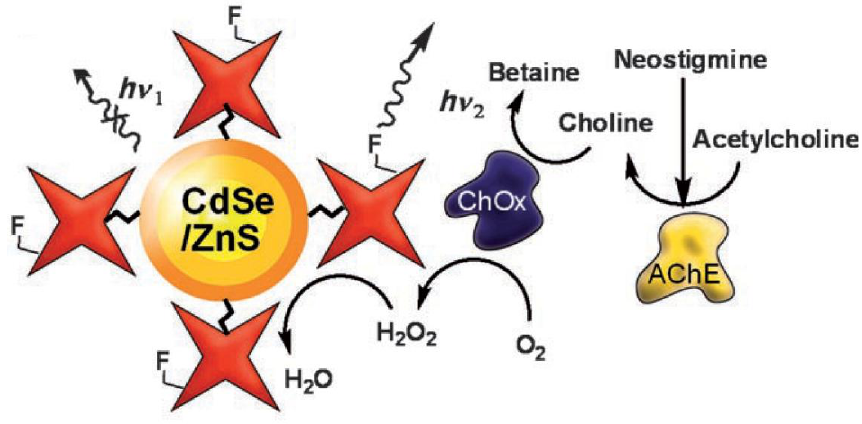
Figure 2. QD-based sensor for anti-acetylcholinesterase (AChE) pesticides: fluorescence of fluorophore-modified avidin-capped CdSe/ZnS QDs is quenched by hydrogen peroxide (H O ) generated by the AChE-choline oxidase (ChOx) biocatalytic cascade; in the 2 2 presence of a pesticide such as the carbamate neostigmine, AChE activity is inhibited, less H O is produced and QDs fluorescence quenching decreases (Reprinted with permission 2 2 from [49], Copyright 2008 Wiley-VCH Verlag GmbH & Co.